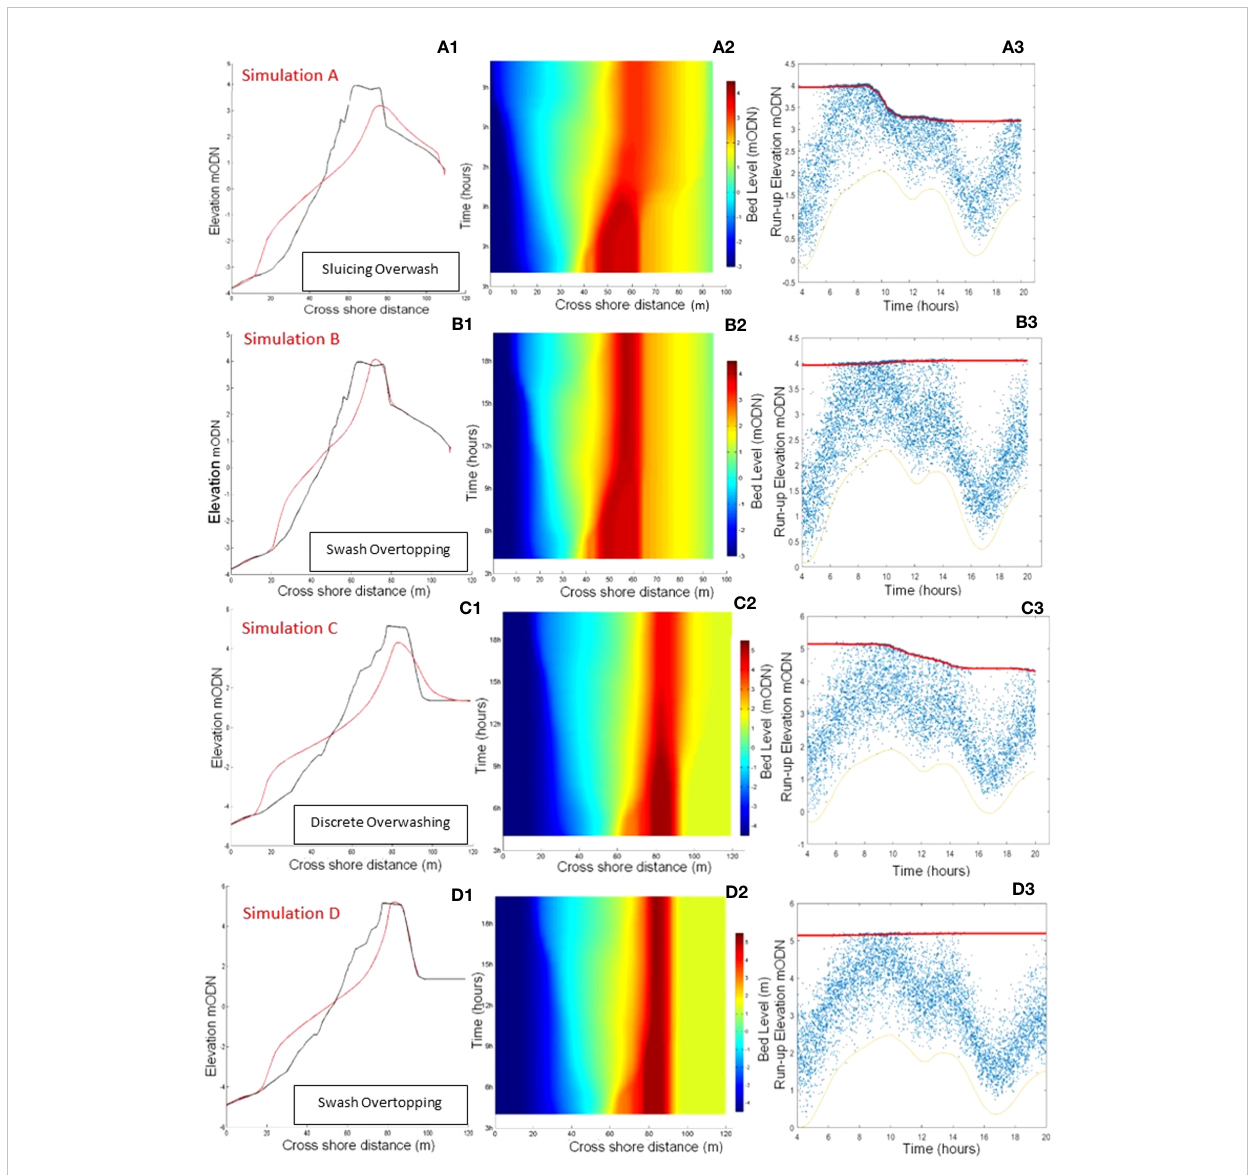
FIGURE 5 Short-term morphodynamic response of Pro fi le 1 and Pro fi le 2 to unimodal storm conditions given in Table 4 (Simulations (A – D) . (A1) , (B1) , (C1) , (D1) - pre storm (black) and post-storm (red) pro fi les; (A2) , (B2) , (C2) , (D2) - spatio-temporal barrier evolution during the storm); (A3) , (B3) , (C3) , (D3) -wave runup (blue crosses) and evolution of barrier crest height (red). Orange Line -